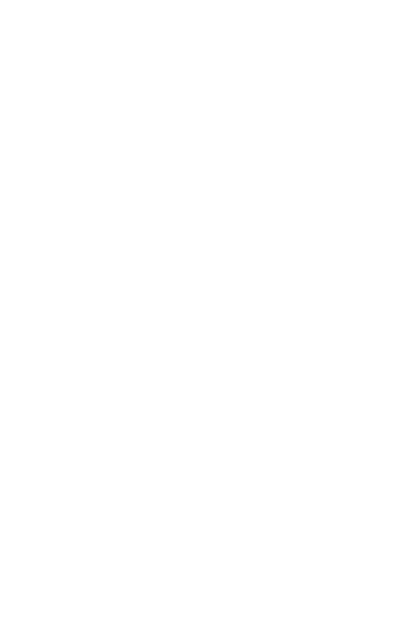
Table 4. Number of patients identified and duration of